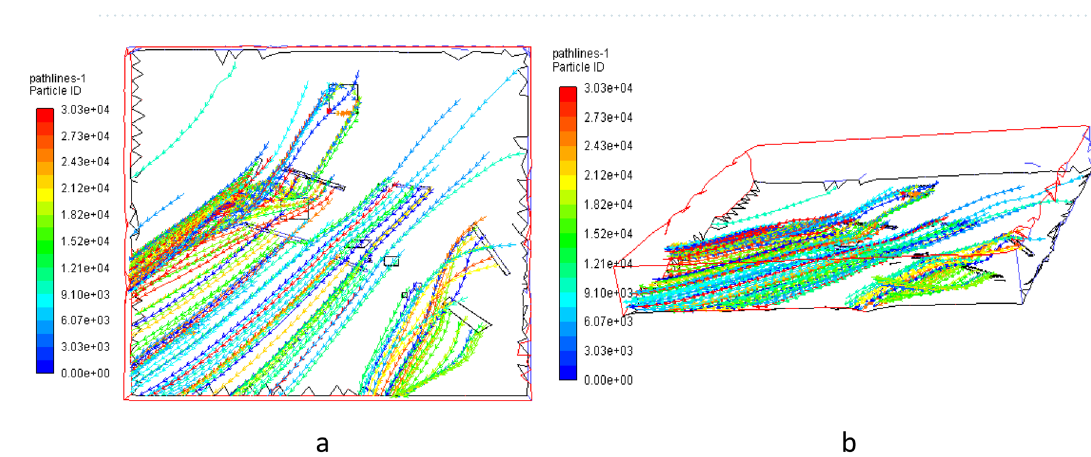
Figure 8. Dust particles migration path under windy condition by Fluent